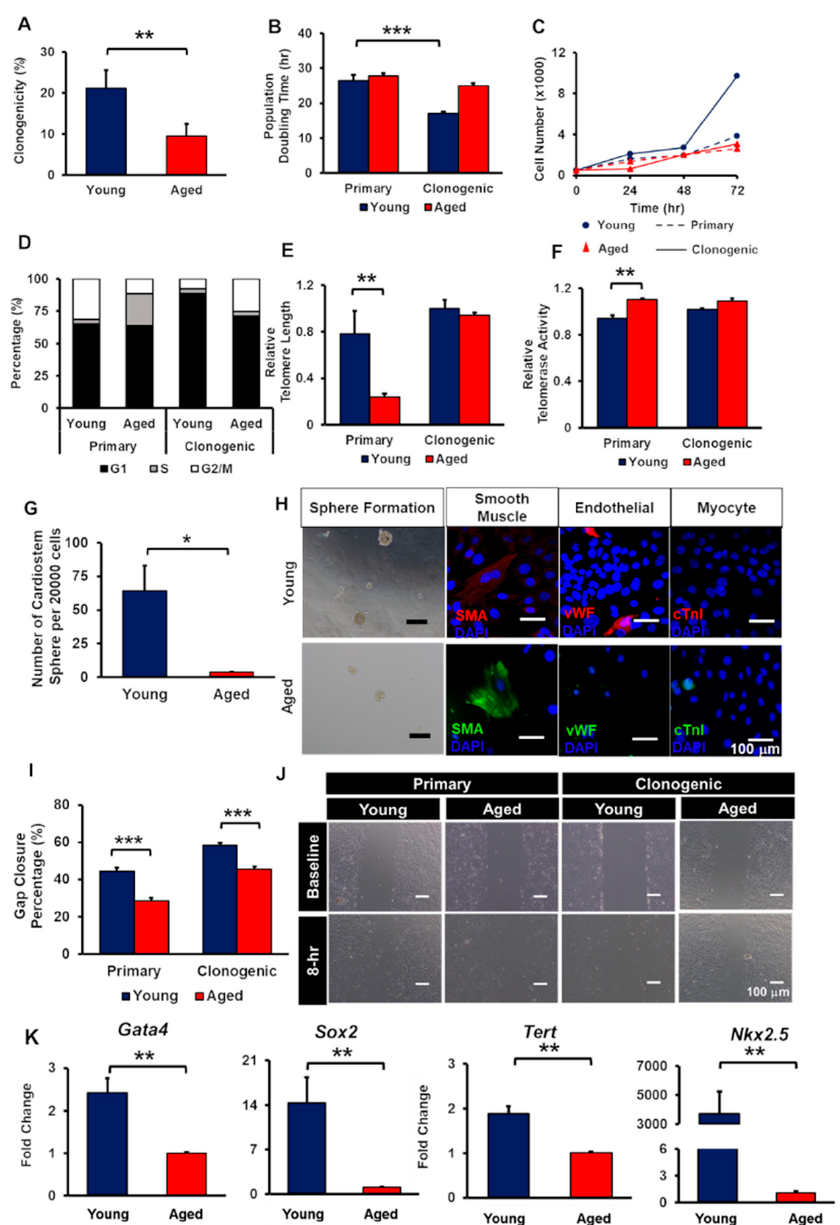
Figure 2. Clonogenically-expanded aged CCs (aCCs) show comparable telomere length to young CCs (yCCs) but functionally impaired compared to clonogenic yCCs. ( A ) Clonogenicity of yCCs and aCCs. ( B ) Population doubling time, ( C ) growth curve, ( D ) cell cycle, ( E ) relative telomere length, and ( F ) telomerase activity of primary isolated and clonogenic CCs. ( G – H ) CardioStem sphere formation and trilineage di ff erentiation. ( I ) migration of both primary and clonogenic CCs. ( J ) Representative images of migrated cells after 8 h. ( K ) Stemness gene expressions. Scale bar = 100 µ m. All data are mean ± SEM. * p < 0.05; ** p < 0.01; *** p < 0.001. ( n = 3). In the primary yCCs, about 65% were in G1 and 31% were in G2 phase (Figure 2D). The primary aCCs were having similar percentage of cells at G1 phase (64%) but with almost 2.5-fold lower percentage of cells in G2 phase as compared to primary yCCs. When CCs were clonogenically expanded, the percentage of cells resided in G1 phase increase to 88% for clonogenic yCCs and 71% for clonogenic aCCs. With almost similar percentage of cells resided in S phase, clonogenic aCCs showed 17% more cells resided in G2 phase (8% vs.